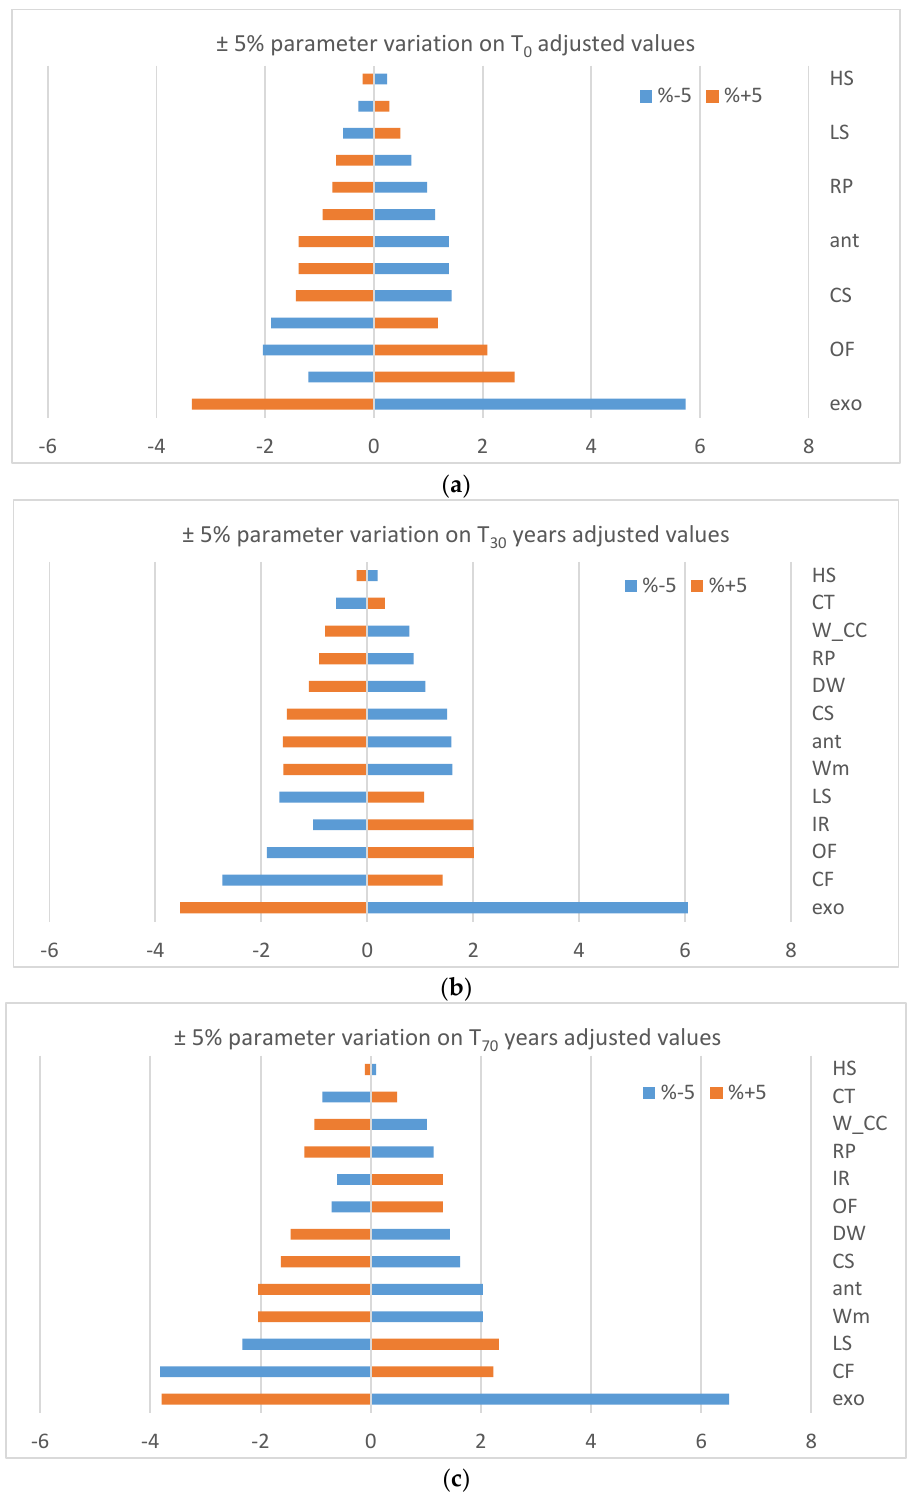
Figure 7. Results of the sensitivity analysis testing a variation of 5% of the adjusted parameter value: ( a ) Adjusted values at T0; ( b ) adjusted values at T 30 ; ( c ) adjusted values at T 70 ; HS: Horizontal structure,